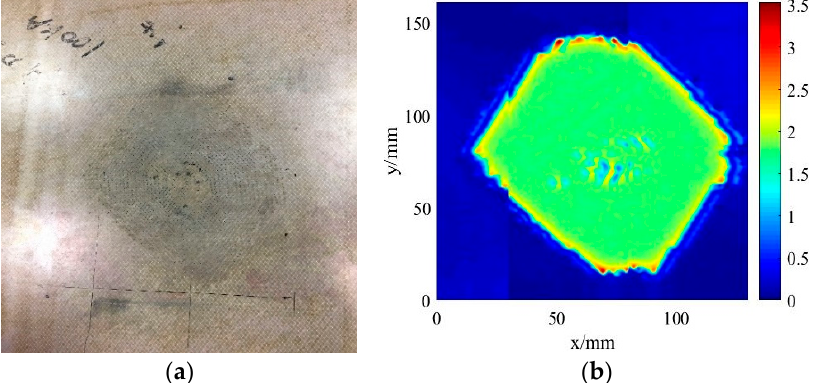
Figure 11. 100 kA current test. ( a ) Impacted specimen, ( b ) Eddy current testing.